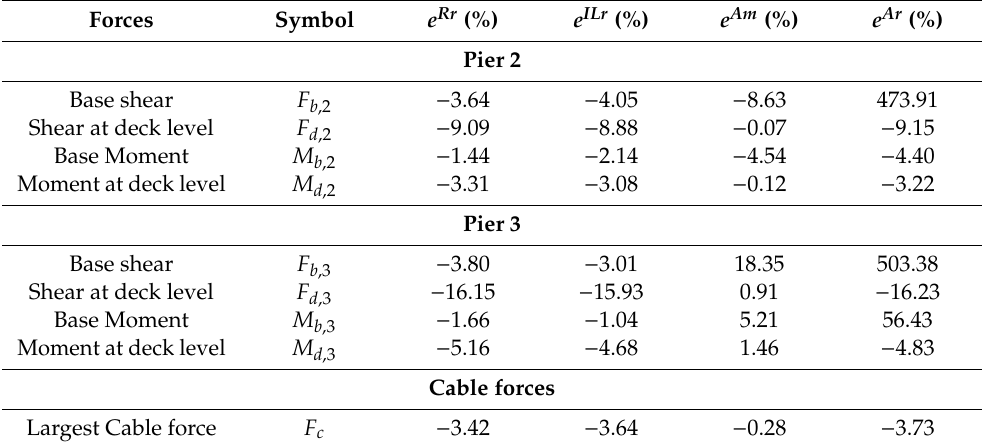
Table 8. Error ratios of the mean peak responses of the responses of cable-stayed bridge.